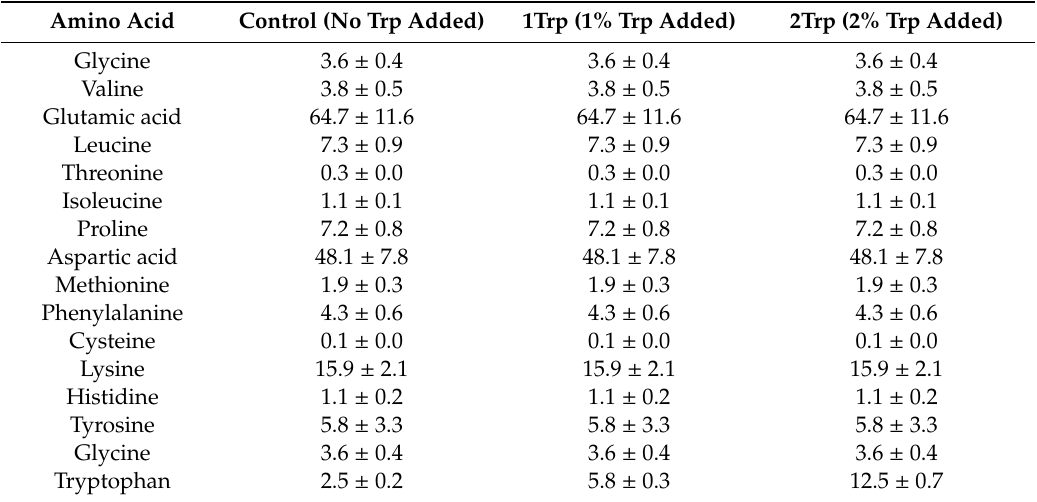
Table 1. Amino acid composition (g amino acid / kg food) for every experimental fish feed (concentration values are mean ±